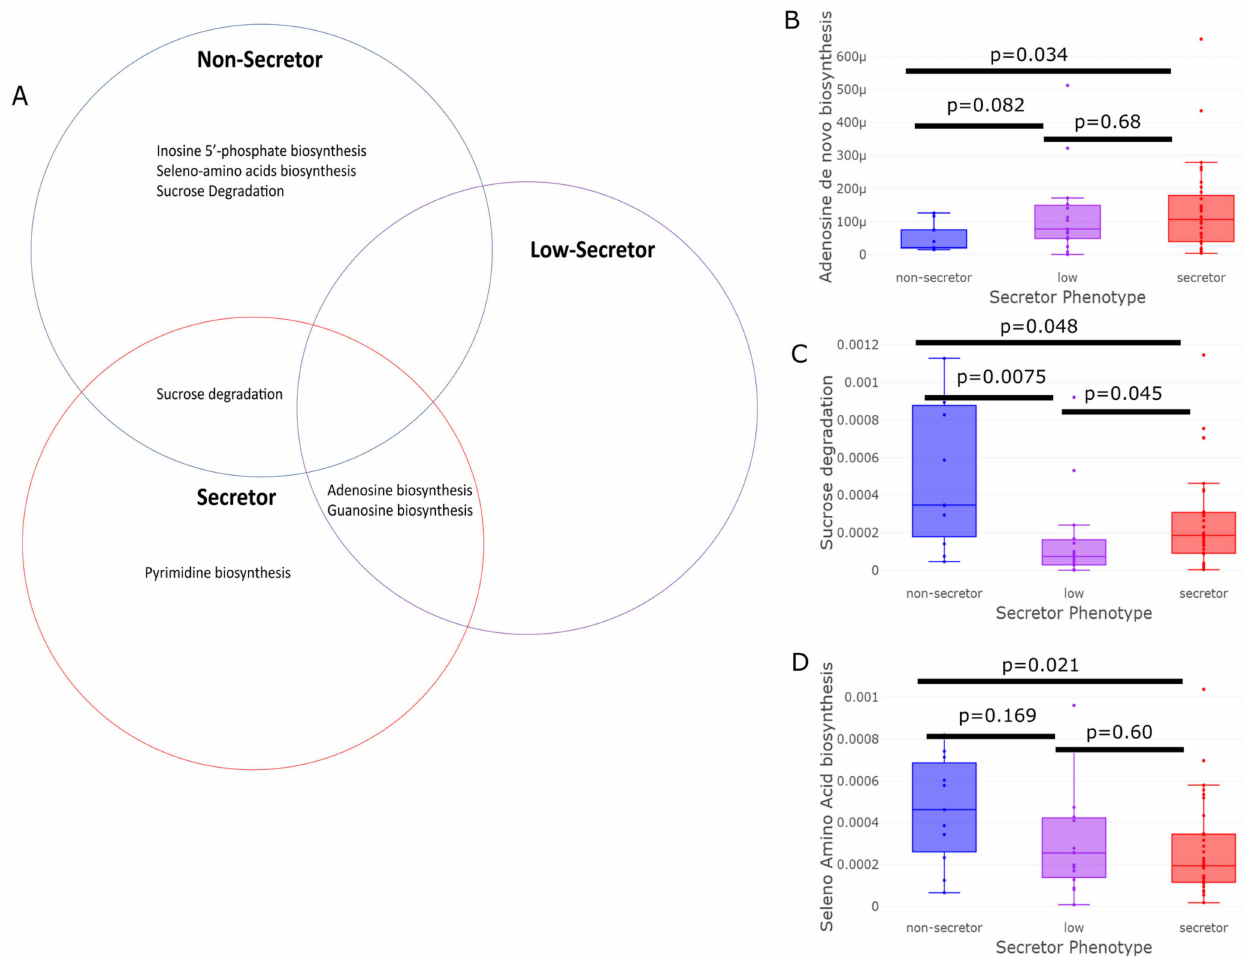
Figure 5. Pathway enrichment of metabolic capacity showing the differences between the secretor phenotypes. The metagenomic sequences were aligned to genes and pathways using HUMAnN2 and compared across the secretor phenotypes using LEfSe. ( A ) The pathways enriched in the full-secretors and low-secretors demonstrated a bioenergetics signature, while the non-secretors had more genes dedicated to the utilization of sucrose and the production of seleno-amino acids. The adenosine and guanosine biosynthesis pathways showed significant increases in the full-secretor individuals (( B ), p = 0.034), whereas the sucrose degradation (( C ), p = 0.0075) and seleno-amino acid biosynthesis pathways (( D ), p = 0.021) were enriched in the microbiota of the non-secretor